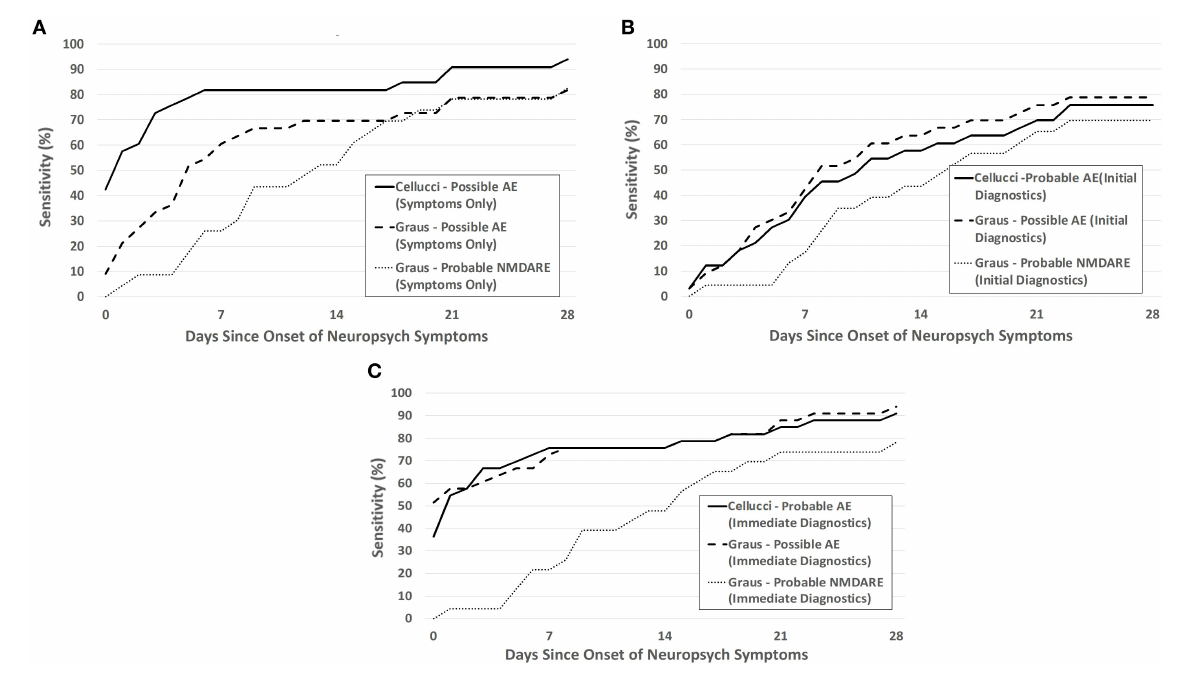
FIGURE3 Sensitivity of the Cellucci and Graus criteria for pediatric AE over the first month after NP symptom onset utilizing (A) clinical symptoms alone (Symptoms Only), (B) both clinical symptoms and initial paraclinical diagnostic testing (EEG, MRI, CSF) without autoantibodies (Initial Diagnostics), and (C) assuming an idealized scenario where diagnostic testing are immediately obtained after meeting symptom criteria (Immediate Diagnostics). The probable NMDARE criteria was applied only to patients with